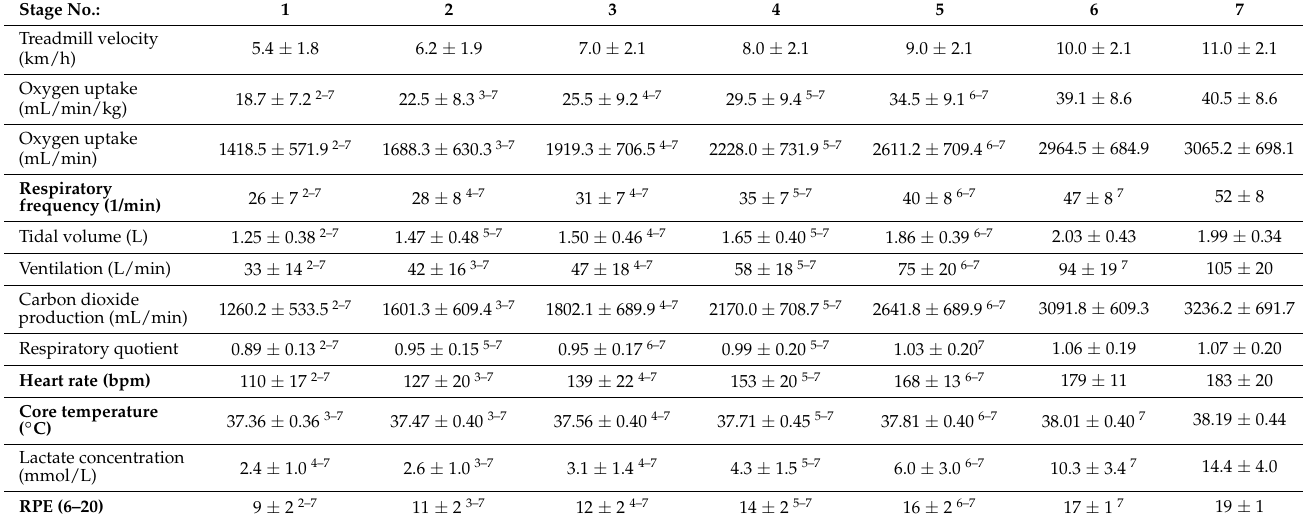
Table 2. Incremental running protocol measured variables (means ± SD) in each 4 min stage. The variables used for extracting the features and labels of the model are in bold. Superscripts represent values significantly different from noted stages (e.g., 4–7 , differences in stages 4, 5, 6 and 7).